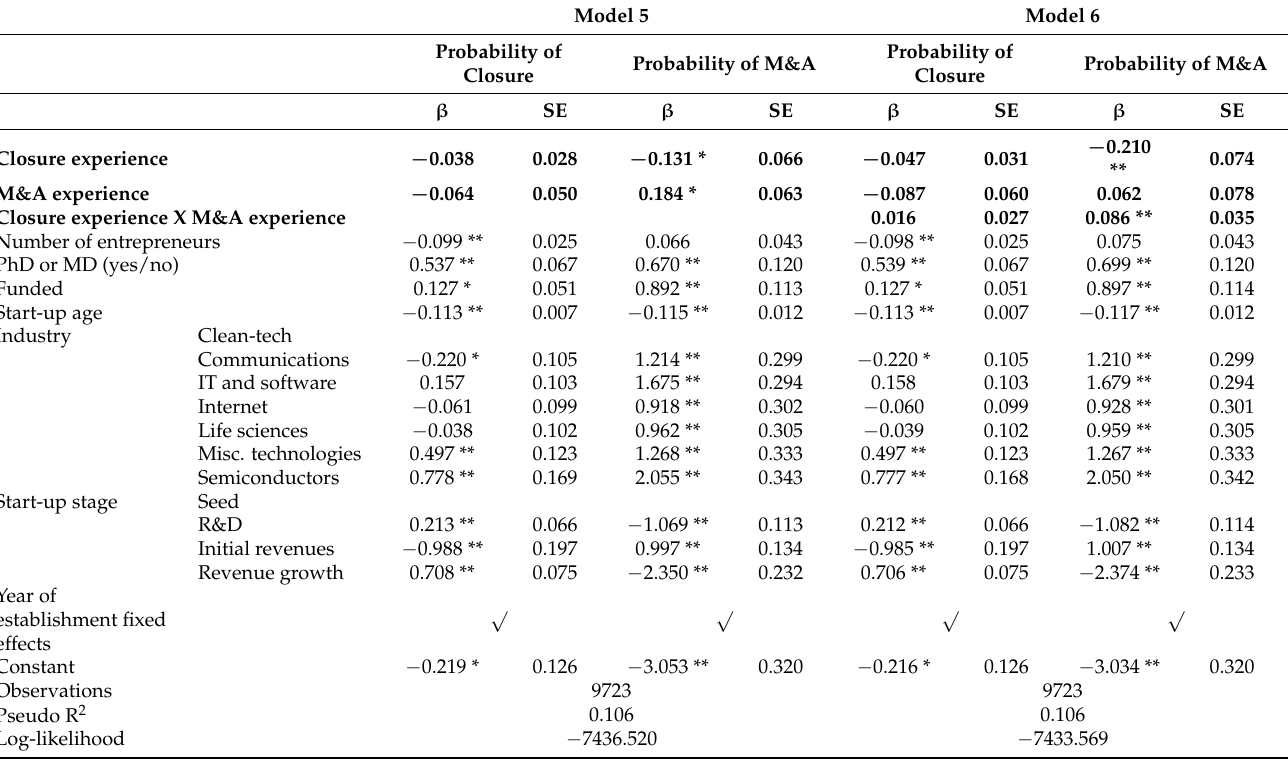
Table 5. The effect of entrepreneurs’ experience on the probability of closure and M&A (compared with the firm remaining